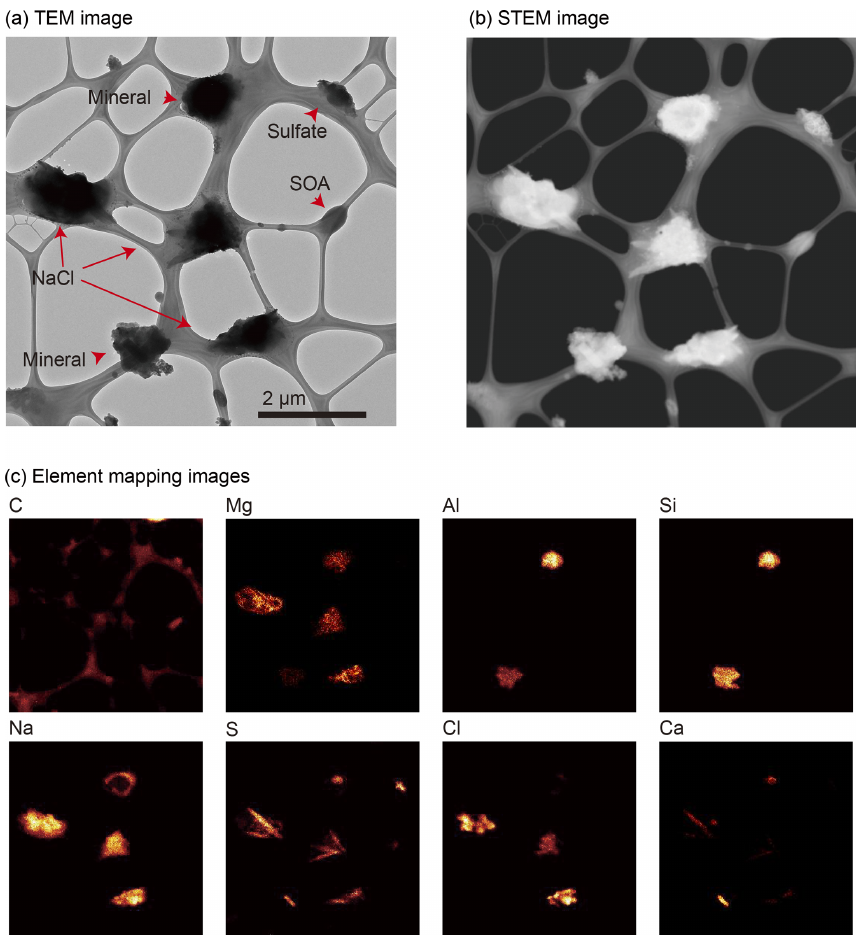
Figure 11. Shapes and compositions of sea-salt particles. (a) TEM, (b) STEM, and (c) element mapping images of sea-salt and mineral particles. These sea-salt particles also contain S as sulfate. The sample was collected from 12:00 to 12:30 on 2 February